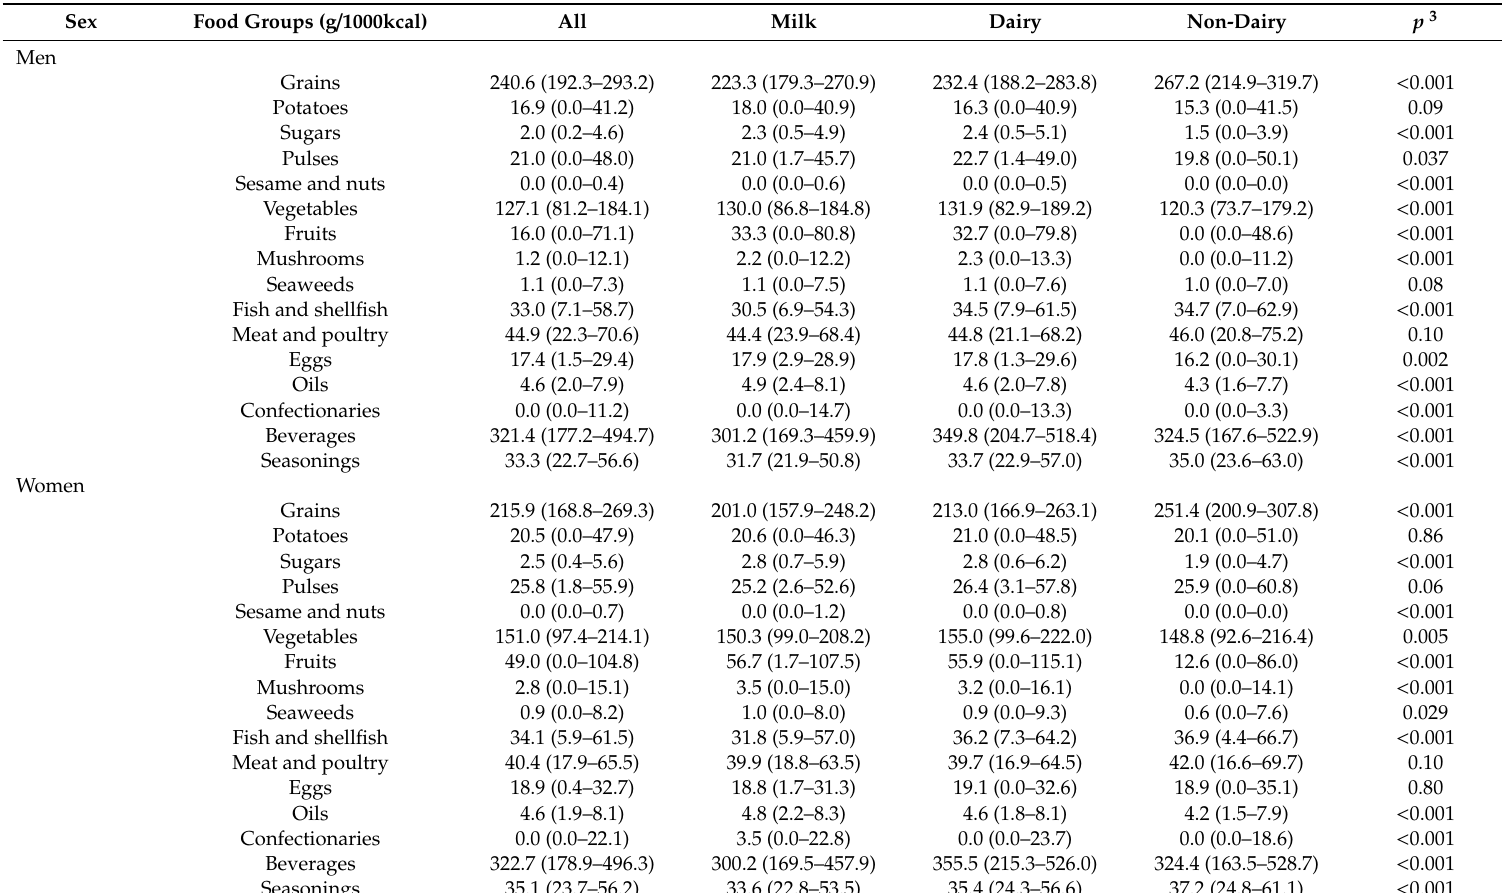
Table 3. Intakes of selected food groups (g / 1000kcal) among 9987 men and 11,619 women according to dairy intake status